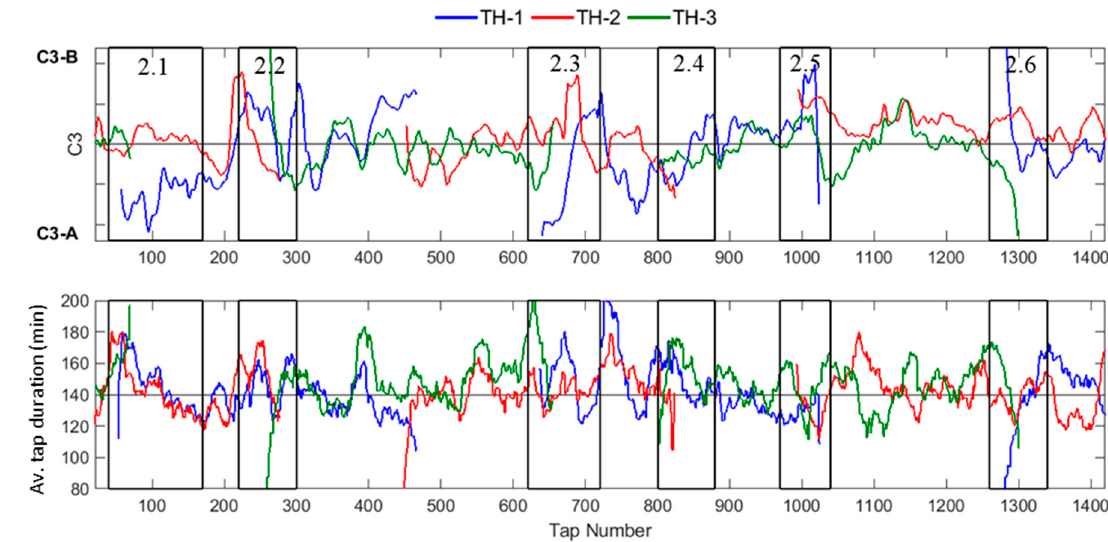
Figure 10. Third principal component (C3, top ) and average tap duration ( bottom ) corresponding to the six periods of Data set 2. Blue line (TH-1), red line (TH-2), and green line (TH-3).